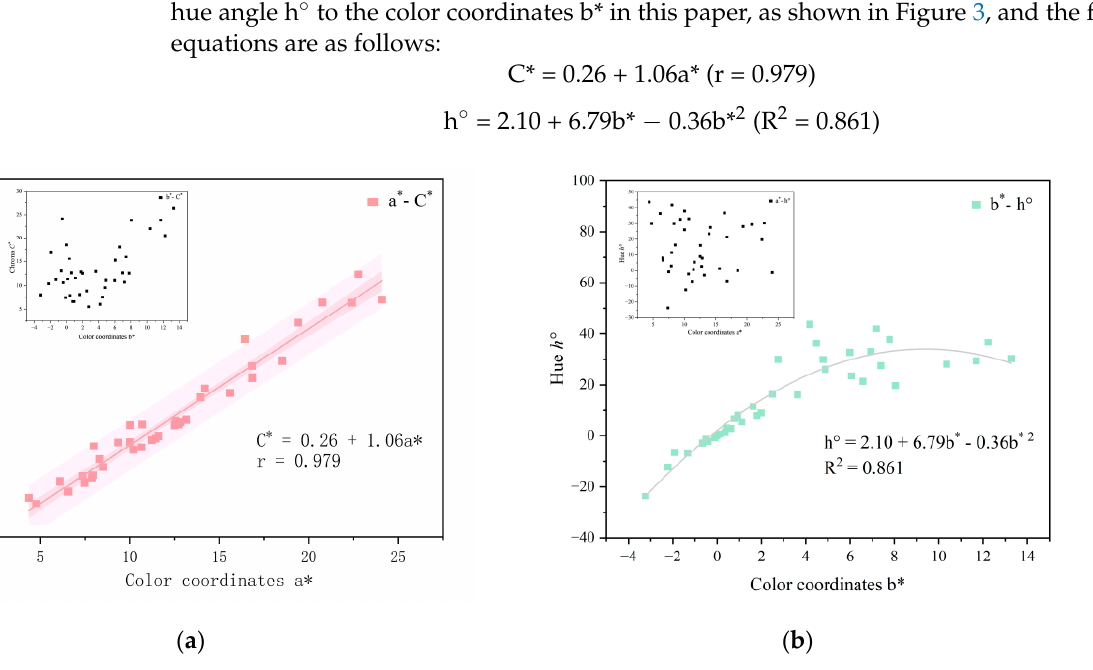
Figure 3. Fitting analysis between color parameters under D65 light source ( a ) Chroma C* and color coordinates a* ( b ) Hue angle h° and color coordinates b*.